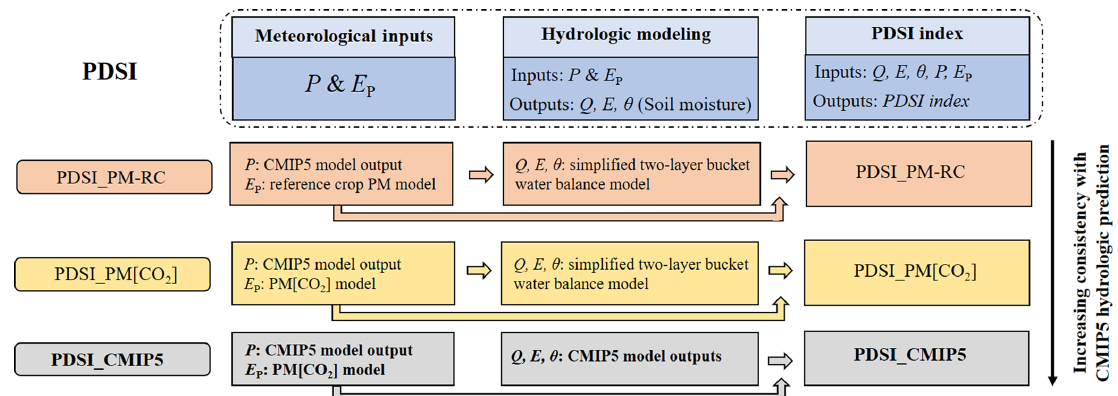
Figure 2. Flowchart of PDSI calculations. Note that PDSI_PM-RC, PDSI_PM[CO 2 ], and PDSI_CMIP5, respectively, follow the right-hand, left-hand, and center columns in Fig.